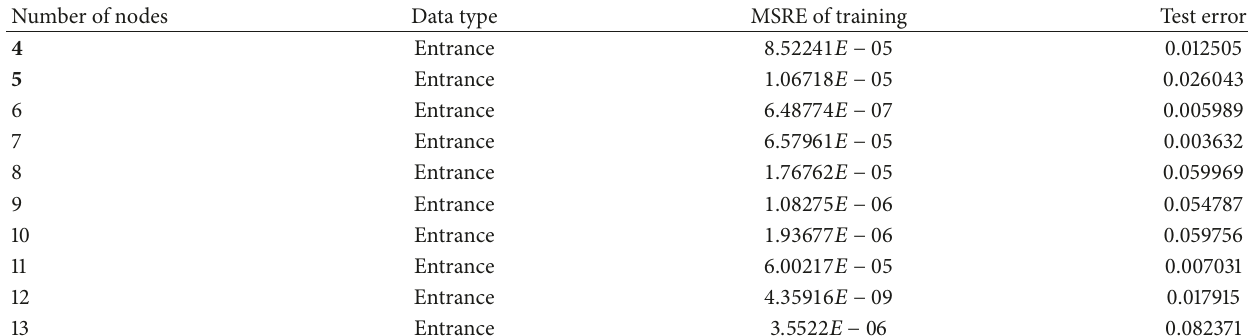
Table 7: Comparison 2 for selection test of number of hidden layer nodes.